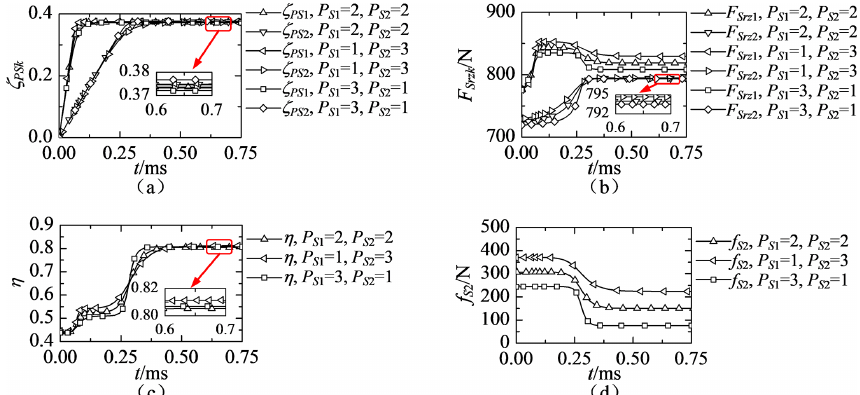
Figure 5. Influence of thread pitches on (a) rotational velocity ratios, (b) axial component of the contact force at the screw # k –roller # k interface, (c) efficiency and (d) friction force between screw #2 and screw